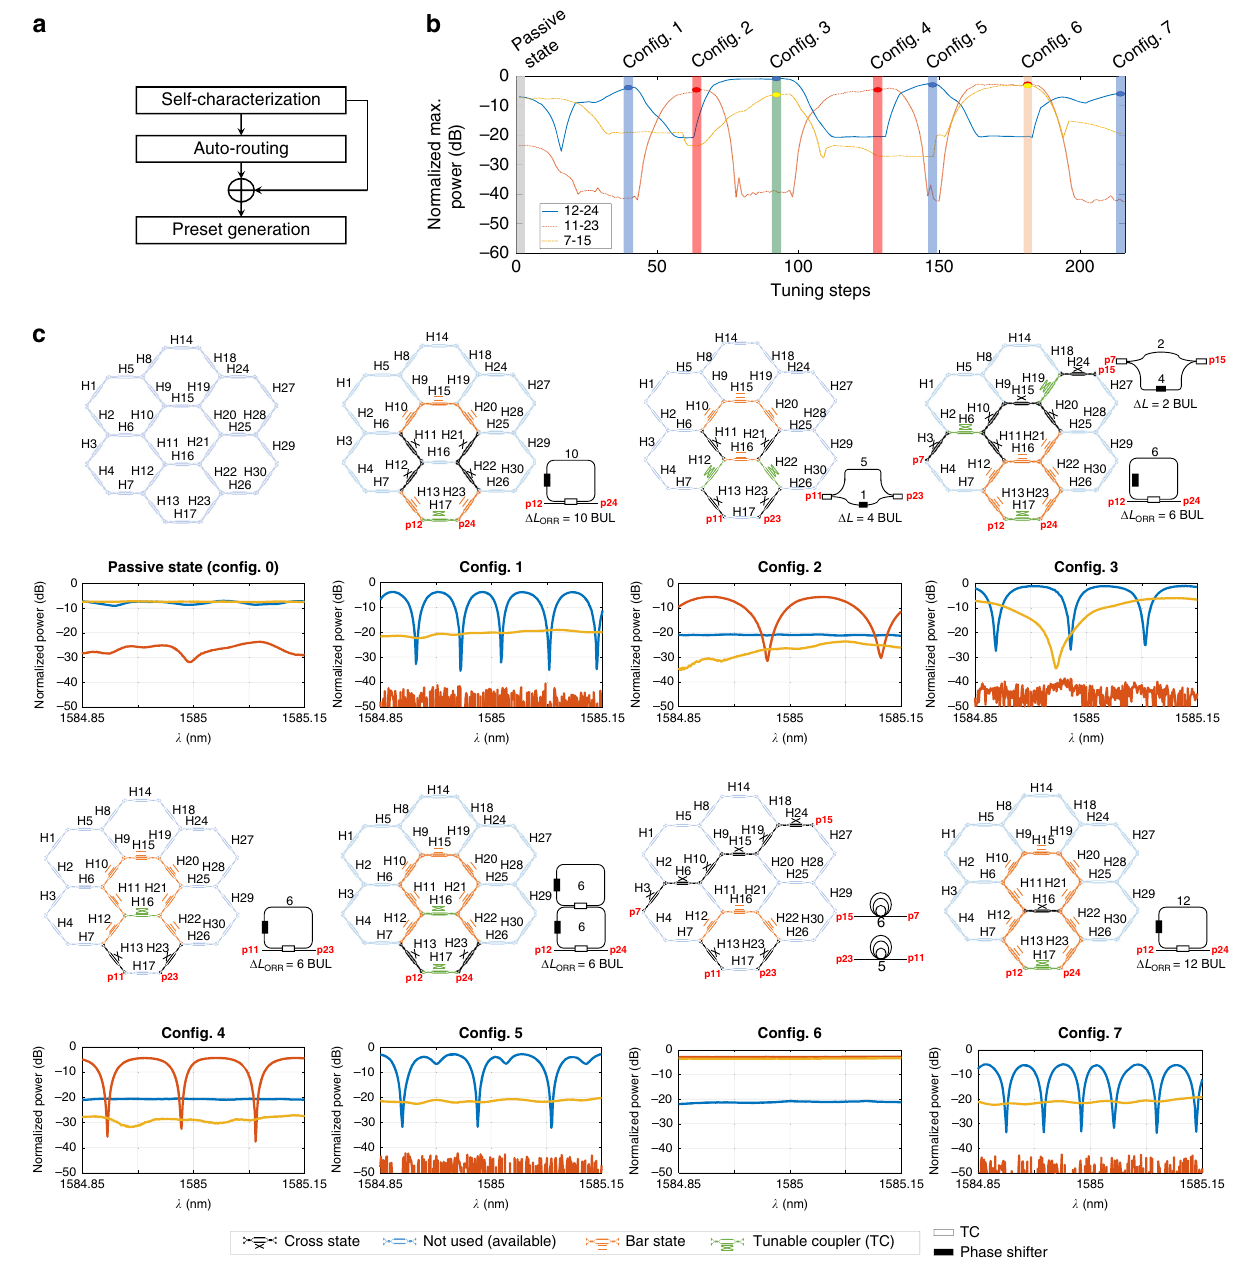
Fig. 2 Experimental results for sequential circuit programing using auto-routing and prior-knowledge-based algorithms. The algorithms are applied to a 30-Tunable Basic Unit hexagonal waveguide mesh with measured normalized maximum optical powers at channels 12 – 24, 11 – 23, and 7 – 17. a Work fl ow of the experiment following a self-characterization routine, the auto-routing algorithm, and the generation of presets, b dynamic con fi guration illustrated by the evolution of the normalized maximum optical power versus tuning steps with maximum current step change of 5 mA allowed per phase actuators for the three optical channels, c the waveguide mesh arrangement with the relevant unit cells con fi gured in passive, cross, bar, or tunable coupling states (up), and the normalized spectral response measured for each circuit con fi guration (down) for the following seven con fi gurations: con fi g 0: passive state, con fi g. 1: optical ring resonator (ORR) de fi ned by 10 basic unit lengths (BULs), con fi g. 2: Mach – Zehnder interferometer (MZI; 4 BUL), con fi g. 3: MZI (2-BUL) and ORR (6 BUL), con fi g. 4: ORR (6 BUL), con fi g. 5: coupled resonator optical waveguide (CROW; 6 BUL), con fi g. 6: delay line (6 BUL) and ORR (6 BUL), and con fi g. 7: ORR (12 BUL). Traces are normalized to a straight waveguide with coupling and propagation loss of 22 algorithm. In our results, we show both the sensitivity to different nonderivative methods depending on whether the computation cost functions de fi nitions, to their speci fi c hyperparameters and of the gradient is employed for each iteration or not; deterministic the statistical behavior of the proposed methods. or stochastic methods depending on the inclusion of random Optimization methods can be classi fi ed according to different variables during the procedure; and individual or population criteria: global and local search algorithms depending on their approaches, depending on the number of search points employed suitability to fi nd the global maximum or their ability to converge during each iteration. In order to test the application of rapidly to their closest minimum point; derivative and optimization methods for the control of large-scale programmable